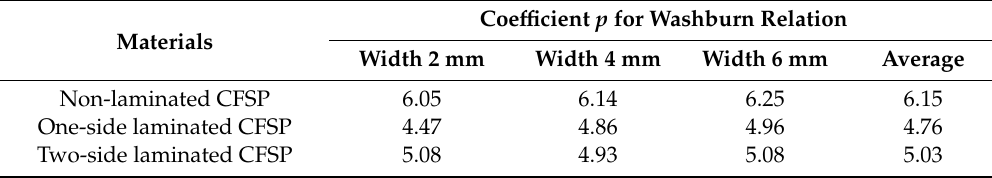
Table 4. Fitting coe ffi cient p of Washburn relation of CFSP